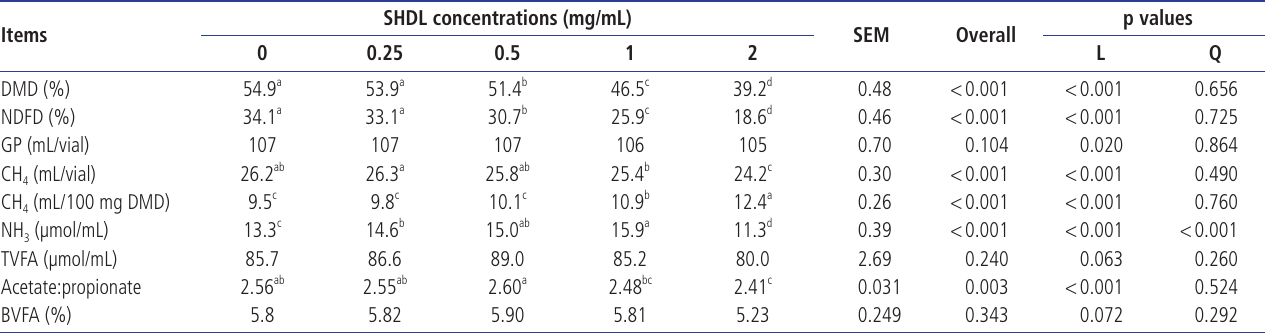
Table 1. Effects of sodium hydroxide dehydrated lignin (SHDL) at 0, 0.25, 0.5, 1.0, and 2.0 mg/mL on ruminal fermentation of alfalfa/grass mixture after 48-h in vitro incubation SHDL concentrations (mg/mL) Items